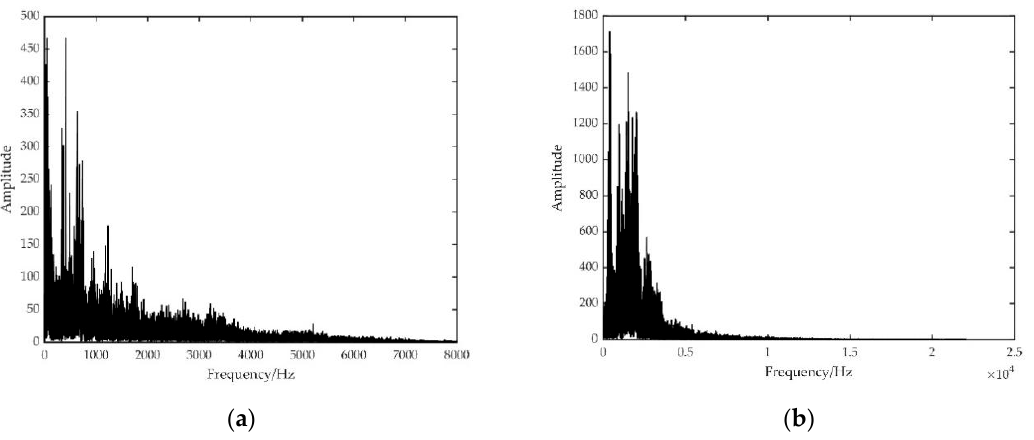
Figure 2. Frequency analysis of environmental noise and pig cough sound signals in pig farms: ( a ) the spectrum of the environmental noise of the pig farm; ( b ) the spectrum of the pig cough sound signals.